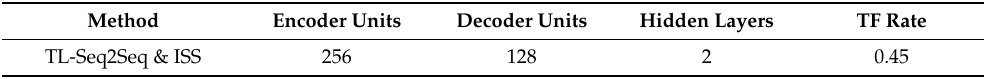
Table 3. The structural parameters of the proposed